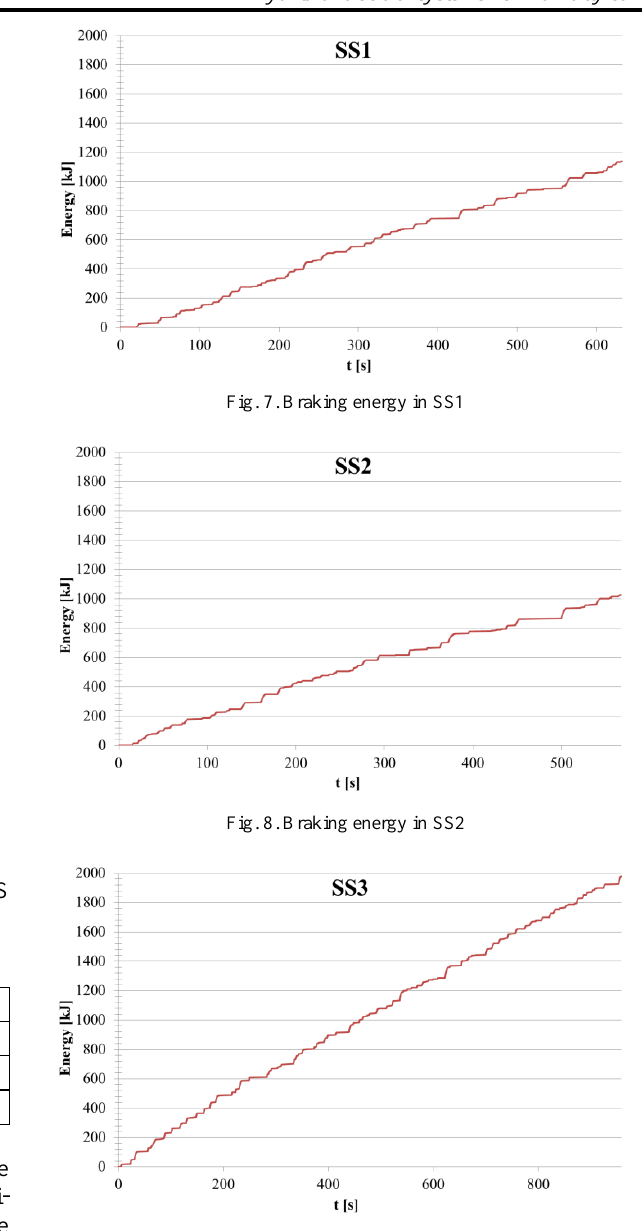
Fig. 9. Braking energy in